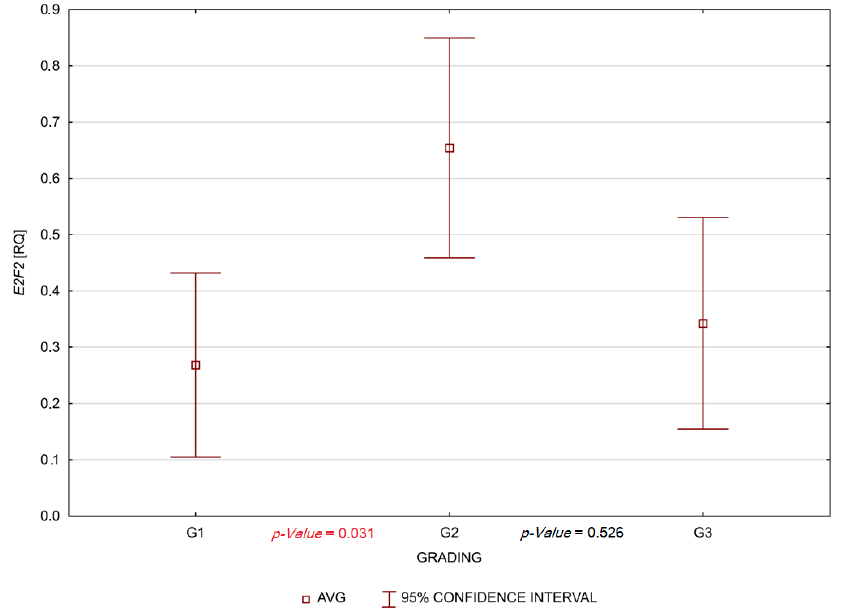
Figure 2. Relative quantification (RQ) values of E2F2 in the group of patients with OSCC according to G1, G2 and G3 in tumour